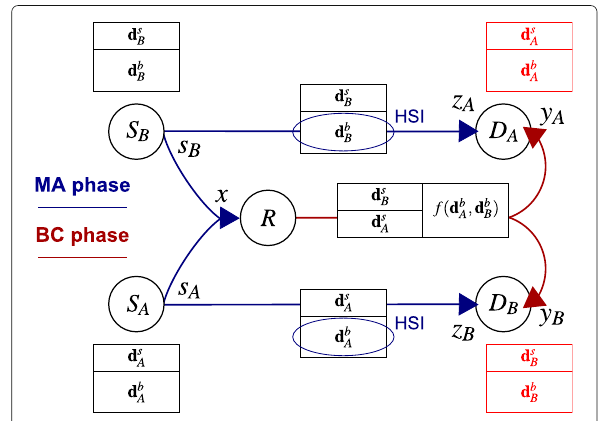
Fig. 1 Symmetric WBN model with half-duplex constraint and two-phase communication